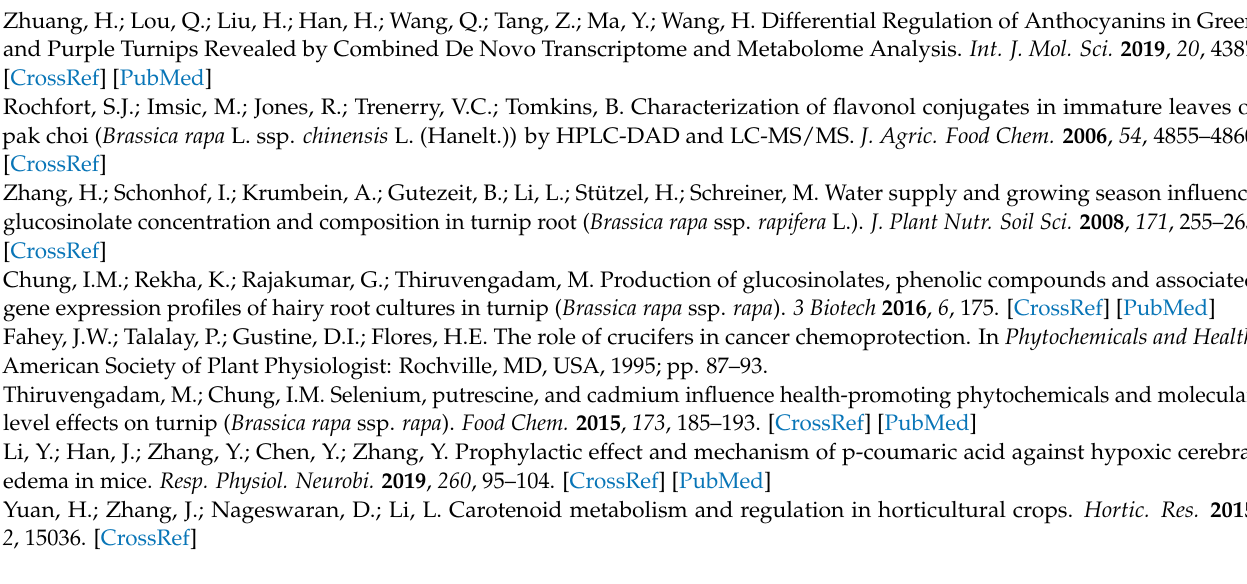
Table S2: The summary of the transcriptome sequencing dataset and quality control; Table S3: The size and distribution of transcripts and unigene length data; Table S4: Coding sequence length and predicted protein sequence analysis data; Table S5: Functional annotation of assembled unigenes in turnip; Table S6: Number of unigenes annotated in seven databases; Table S7: Gene Ontology classification of unigenes in turnips; Table S8: EuKaryotic Ortholog Groups classification of unigenes in turnips; Table S9: The identified differentially expressed TFs in two turnips at three development stages; Table S10: The FPKM values of 125 differentially expressed unigenes involved in the carotenoid biosynthesis pathways; Figure S1: The column diagram of transcripts, unigene, coding sequences and predicted protein sequence size and distribution in